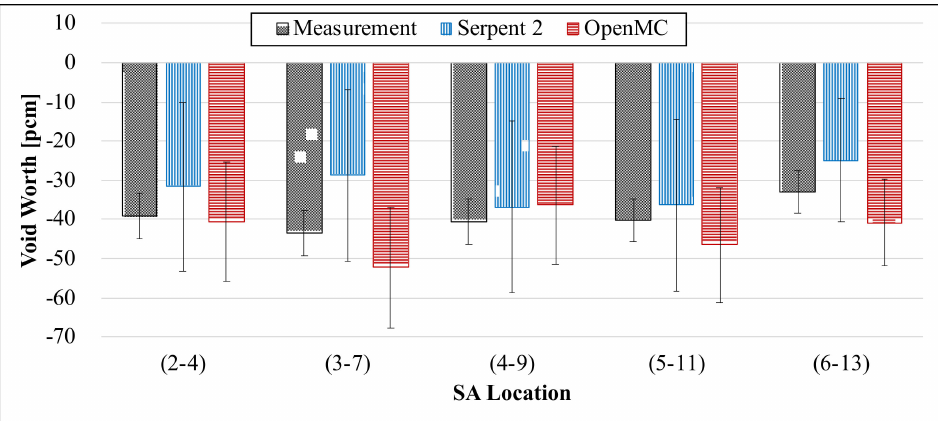
Figure 11. Sodium-void